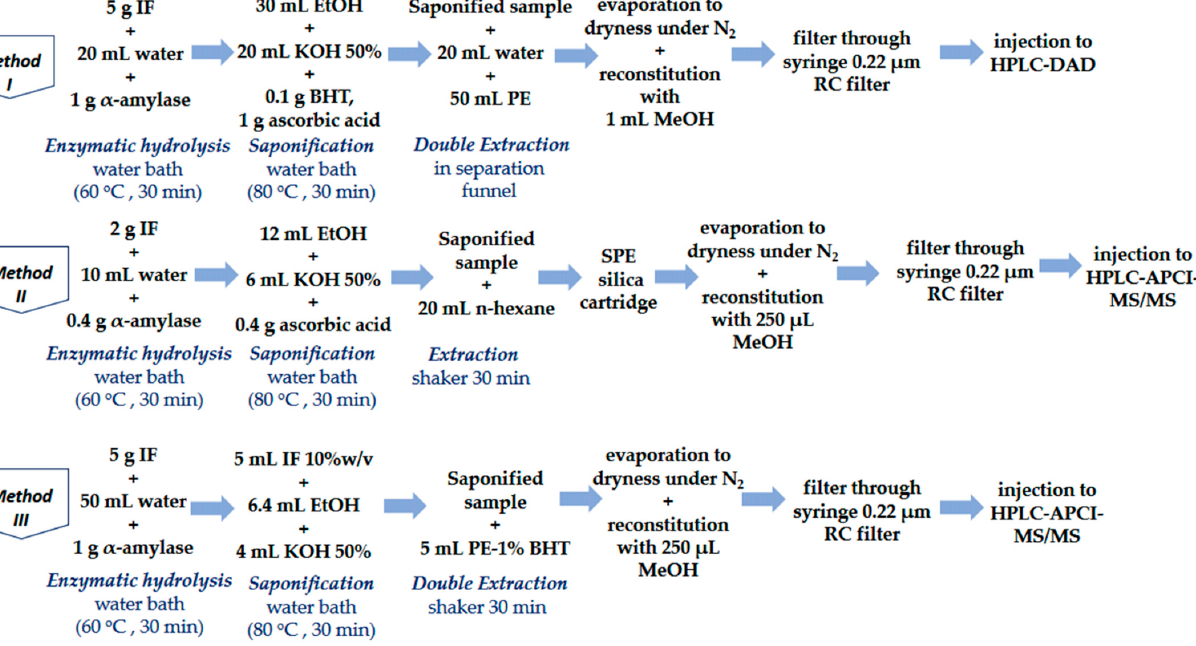
Figure 1. Schematic illustration of the experimental procedures of Methods I-III.